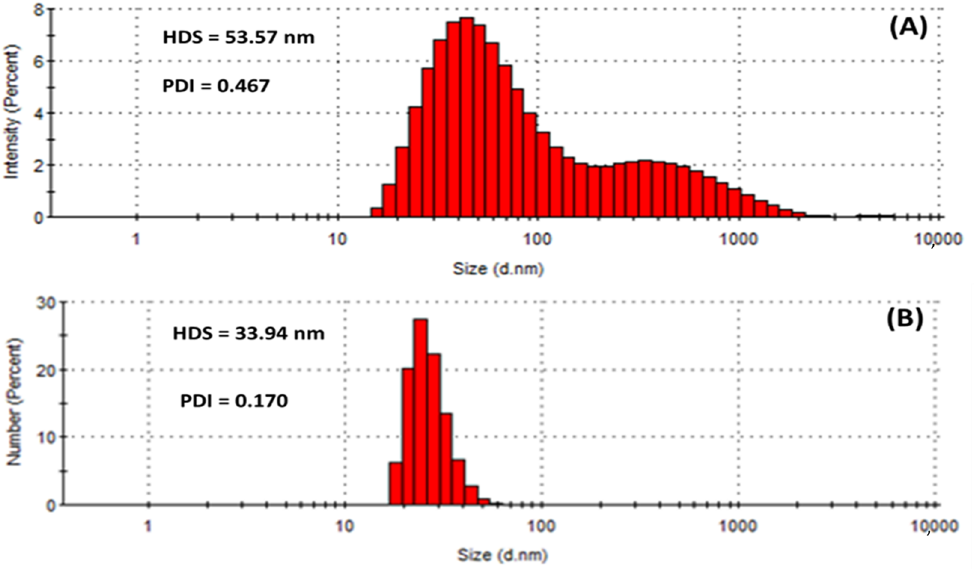
Figure 5. Hydrodynamic size (HDS) and polydispersity index (PDI) showing the population of par- ticles in ( A ) HE-AgNPs and ( B ) HP-AgNPs.